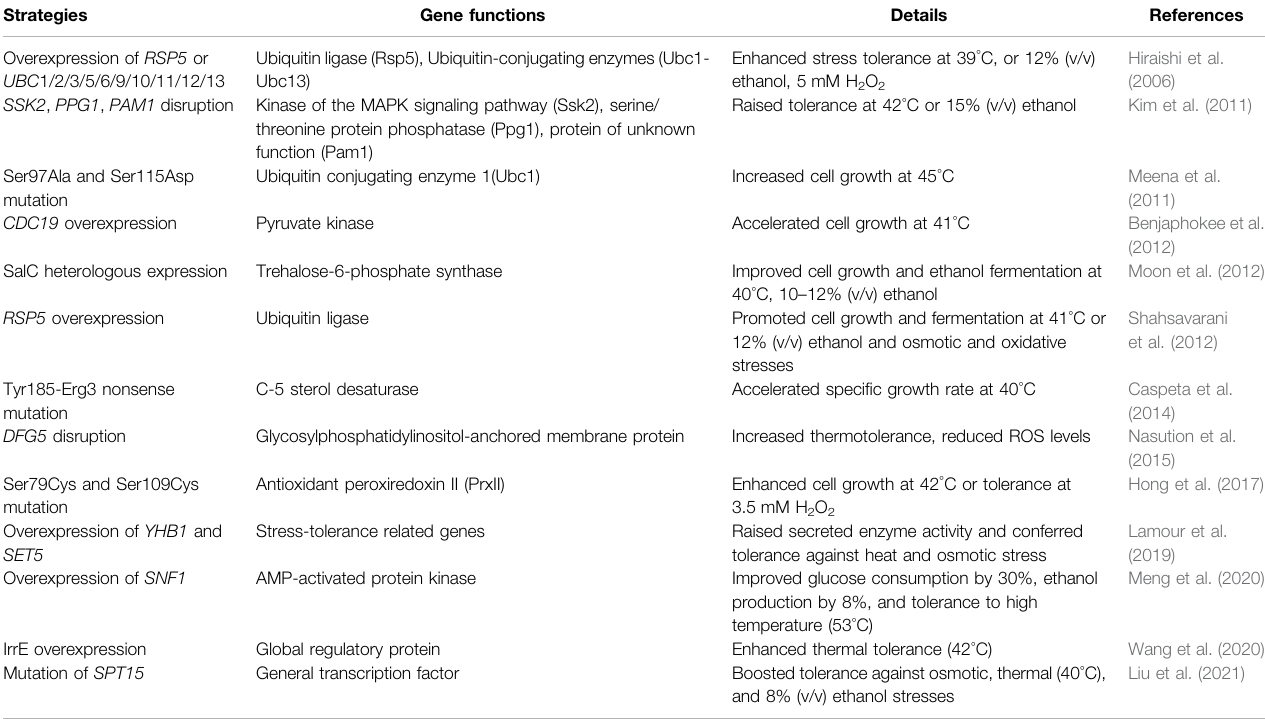
TABLE 2 | Representative examples of improved thermal tolerance of S. cerevisiae by genetic engineering. Strategies Gene